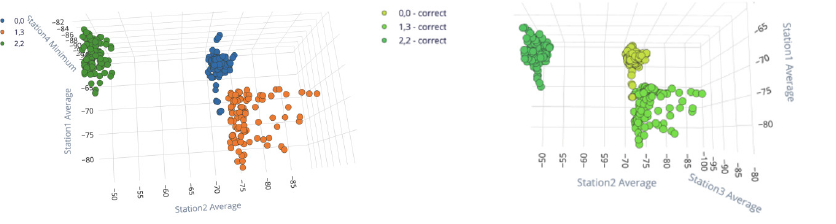
Figure 19. On the left, the features generated by the Flatten input block, with one color per loca- tion/label, and on the right the classification results for the same dataset (all in green, all correctly classified). Taken from [24].